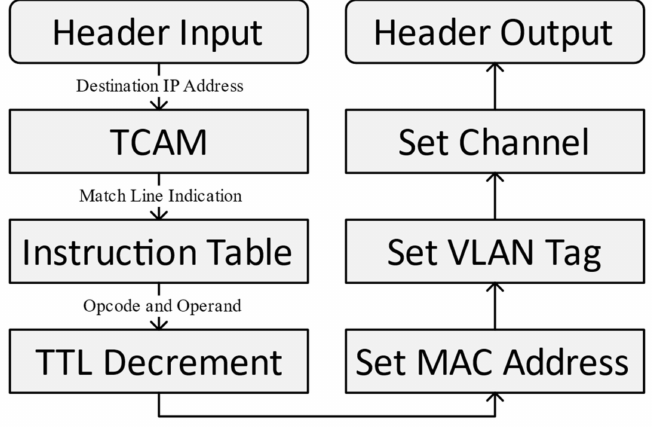
Figure 3. Match-Action